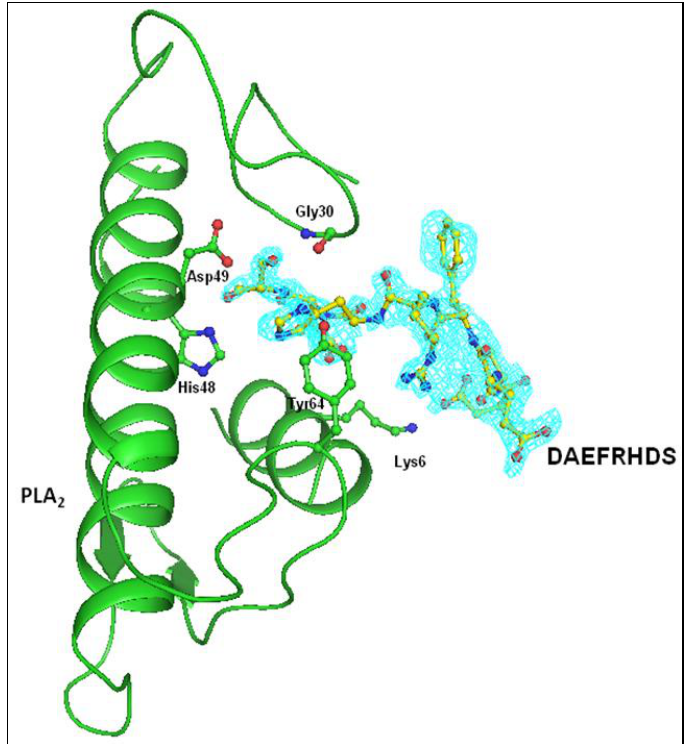
Figure 3. The |F − F | electron density map contoured at 2.0 σ showing the electron o c density for the peptide Asp-Ala-Glu-Phe-Arg-His-Asp-Ser.